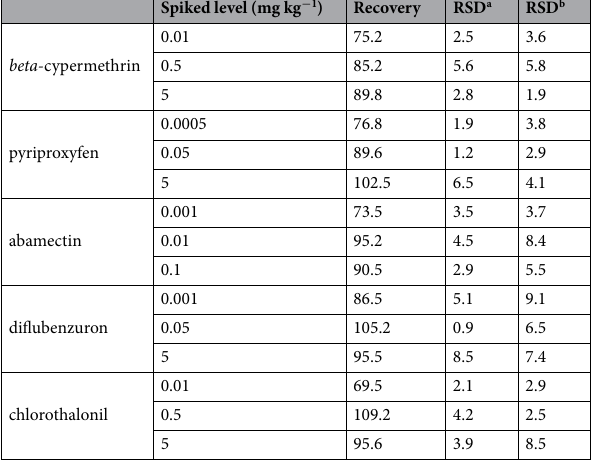
Table 2. Recoveries (n = 5, %) and RSDs (%) for target compounds from soil. a Intra-day (n = 5). b Inter-day (n =